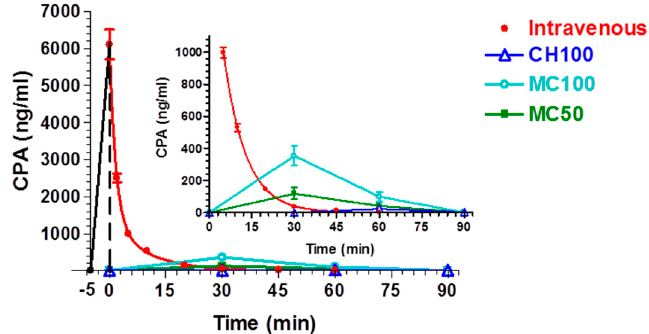
Figure 6. Blood CPA concentrations (ng/mL) after infusion or nasal administration of a 200- µ g dose. The time ranging from − 5 to 0 min refers to CPA IV infusion. In the inset: zoom of the same plot with expanded Y-scale (CPA blood concentration) from 0 to 1000 ng/mL. The inset highlights the concentration values obtained after administration of CH100, MC100 and MC50. Data are expressed as the mean ± standard deviation, n = 4.